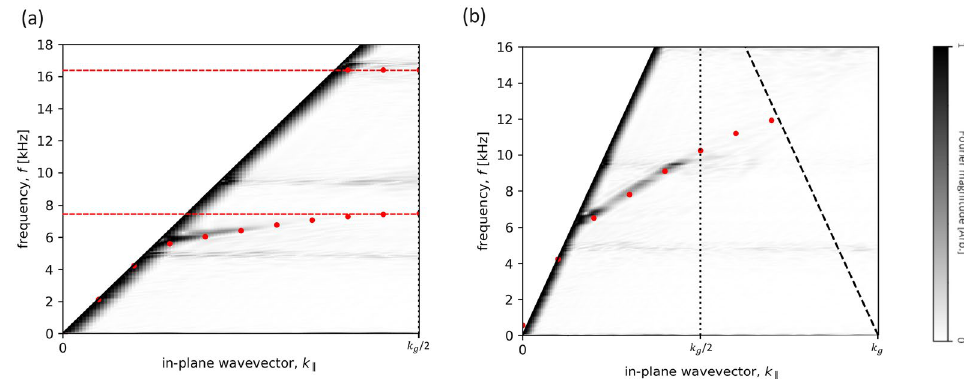
Figure 6. Experimental dispersion for the sample in both ( a ) mirror symmetry and ( b ) glide symmetry arrangements, with surface separation, h = 0.5 mm. Absolute Fourier amplitude is shown as a function of frequency and in-plane wavevector k (cid:31) with the colour representing the Fourier amplitude. Data has been normalised using slices in frequency. Solid black lines represent the sound-line ( k 0 ) and dashed black line the diffracted sound-line with vertical dotted lines indicating the first BZB at k (cid:31) = k g / 2 . Red points show eigenfrequency predictions from a loss-inclusive numerical model. Red dashed lines represent the formed bandgap.